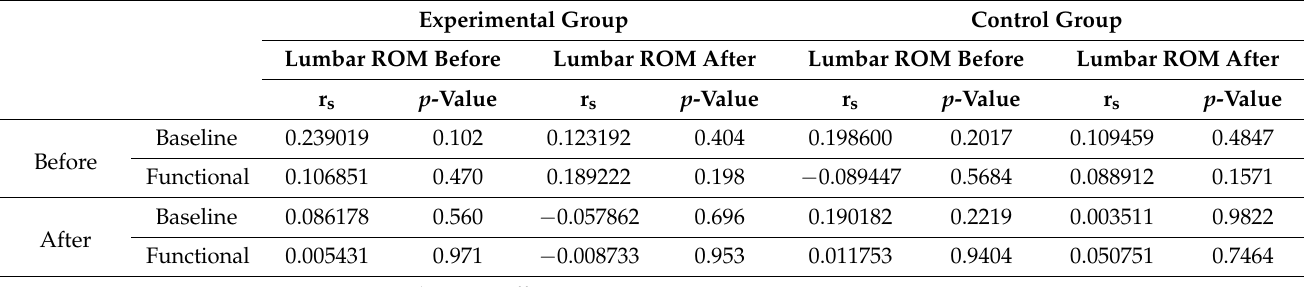
Table A1. Correlation between the bioelectric activity ( µ V) of the erector spinae muscles and the ROM of the lumbar spine in the experimental and control groups.